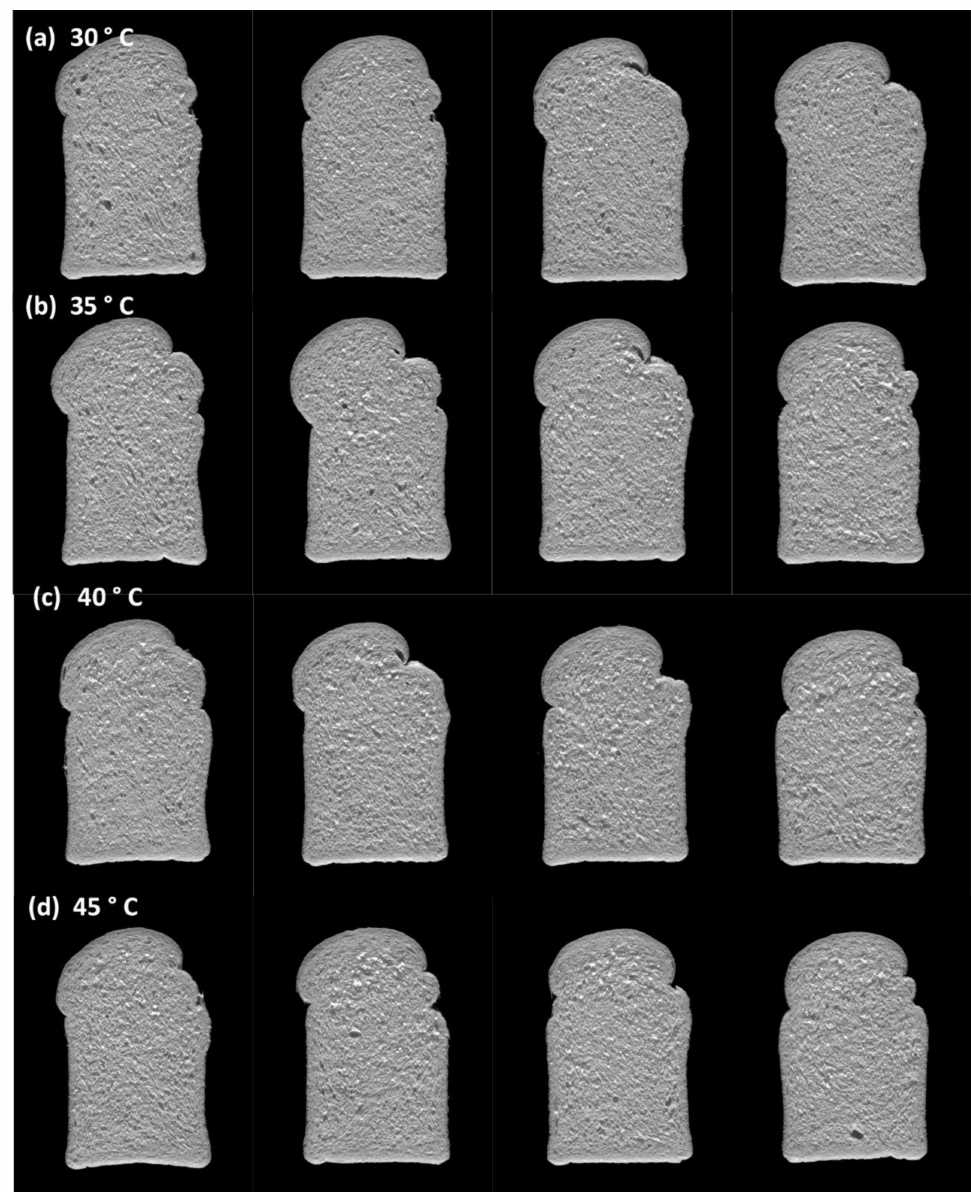
Figure 13. Slices of bread made with ferment prepared using varying fermentation temperatures. ( a ) 30 ◦ C, ( b ) 35 ◦ C, ( c ) 40 ◦ C, and ( d ) 45 ◦ C. Left to right: control (no ferment), 30% ferment inclusion, 50% ferment inclusion, and 70% ferment